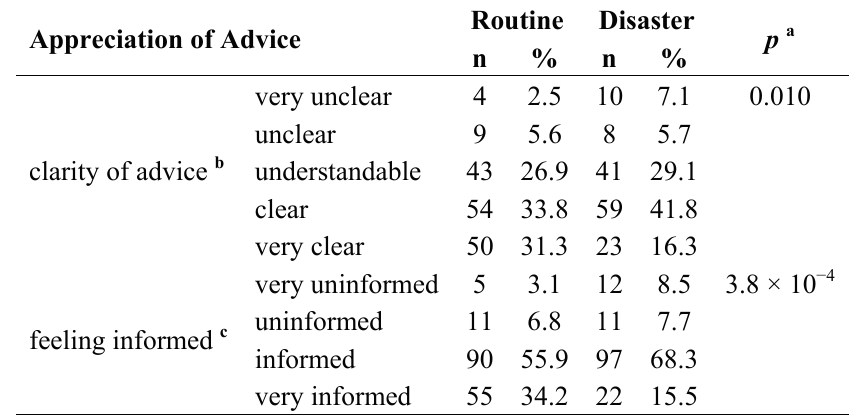
Table 4. Comparison of clarity of advice and feeling informed between routine incident and natural disaster respondents.